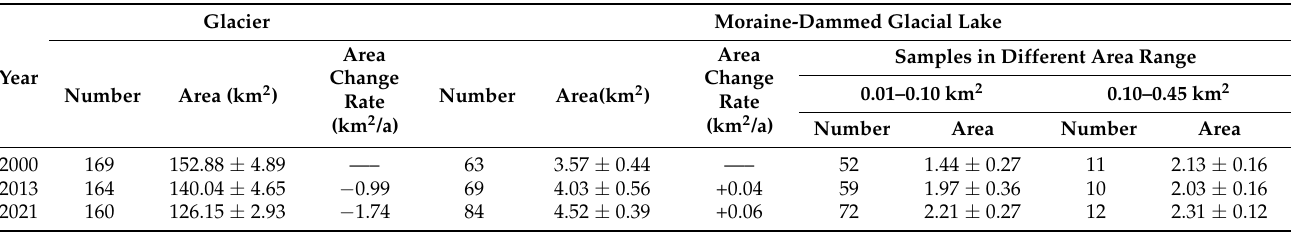
Figure 2. Outlines of glaciers and moraine-dammed glacial lakes in 2000, 2013 and 2021. The location of areas shown in subfigures ( a – d ) is denoted by the dashed red rectangles R1–R4 in Figure 1, respectively. Numbers over glacier areas mark the glaciers mentioned in the text. The background is the Sentinel-2 image acquired on 12 October 2021. Table 2. Changes in the number and area of glaciers and moraine-dammed glacial